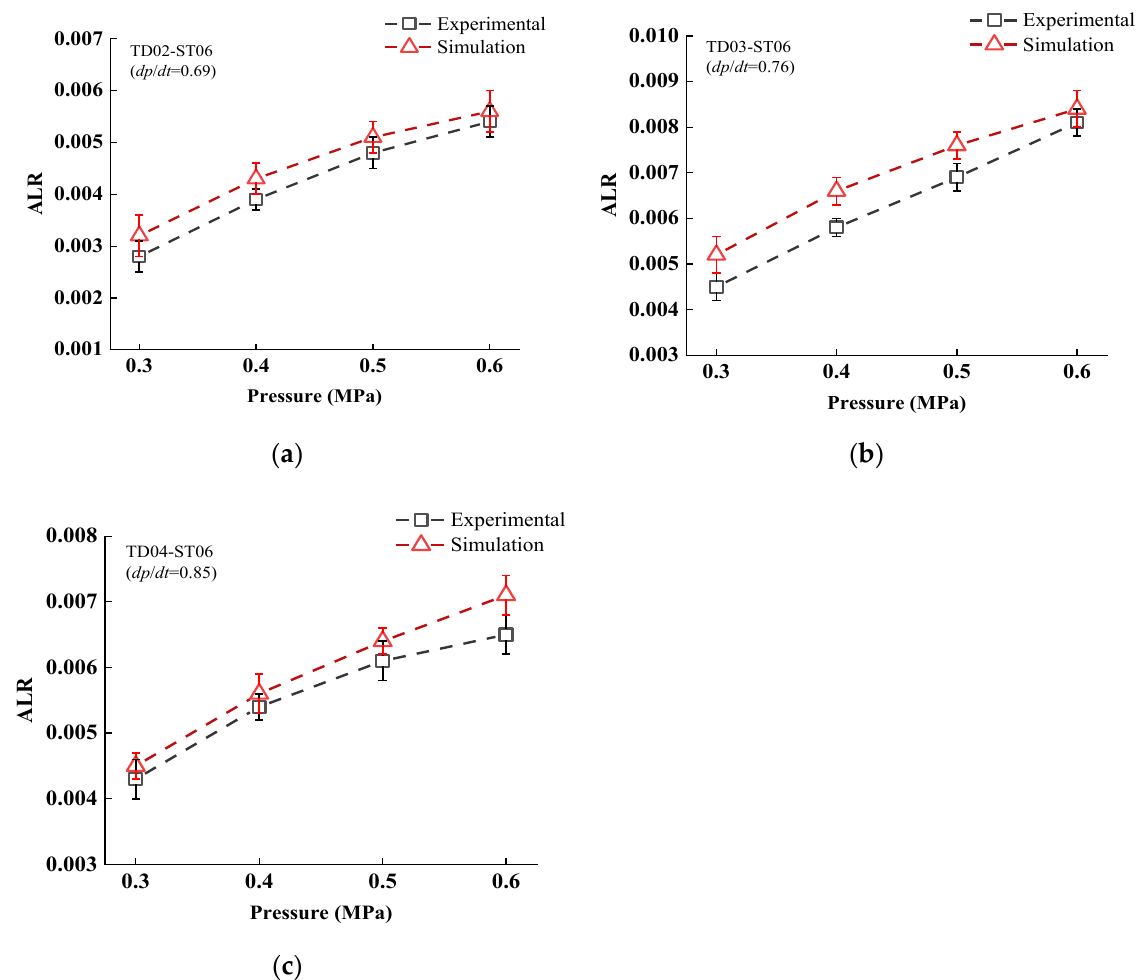
Figure 12. ALR of simulation and experiment: ( a ) TD02-ST06 combined AIN; ( b ) TD03-ST06 com- bined AIN; and ( c ) TD04-ST06 combined AIN.